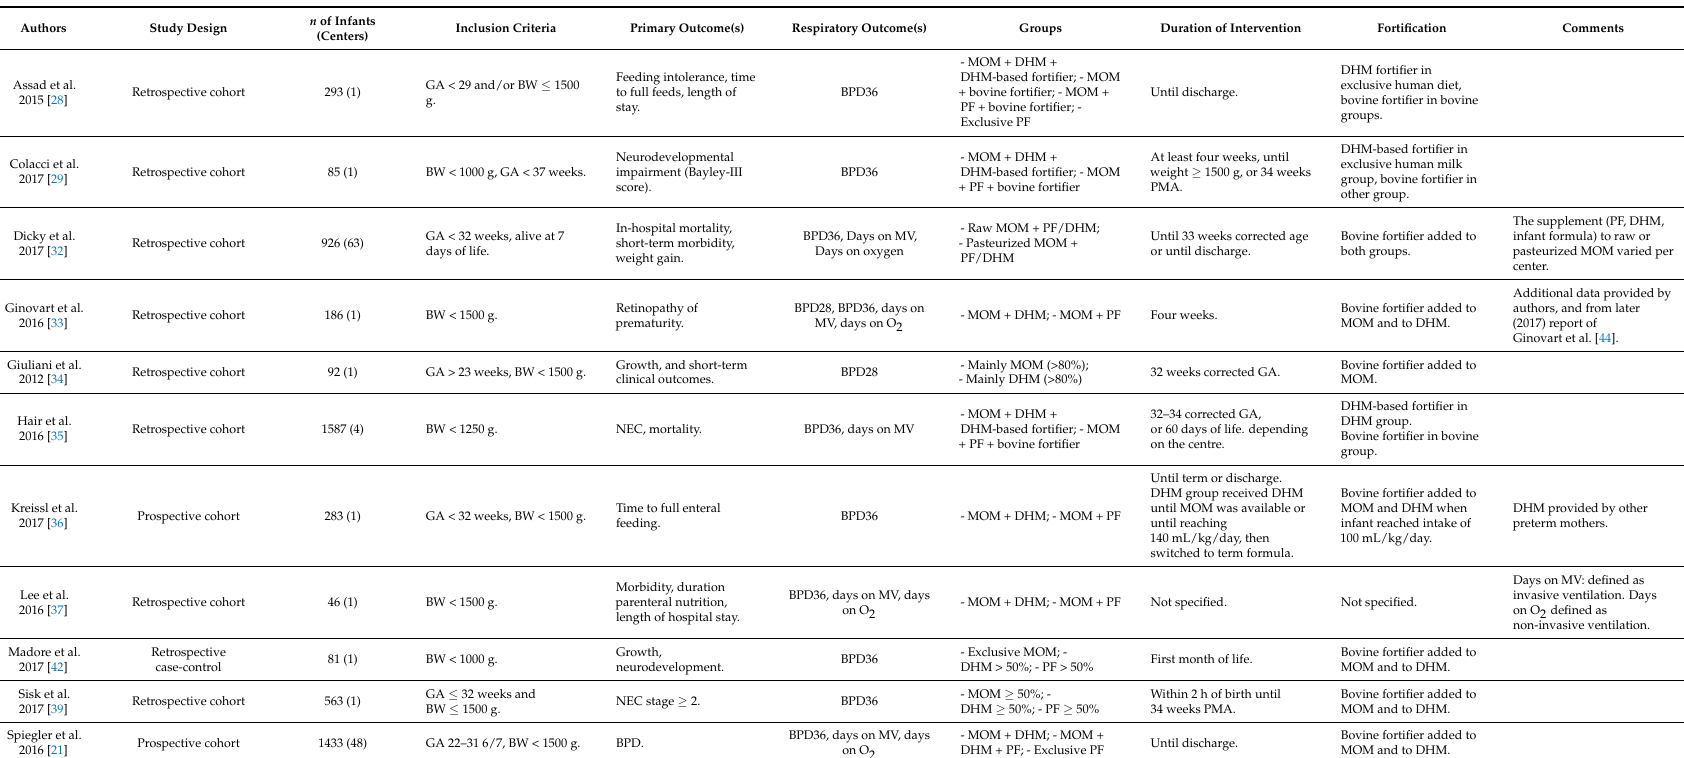
Table 2. Synoptic table of characteristics of included observational